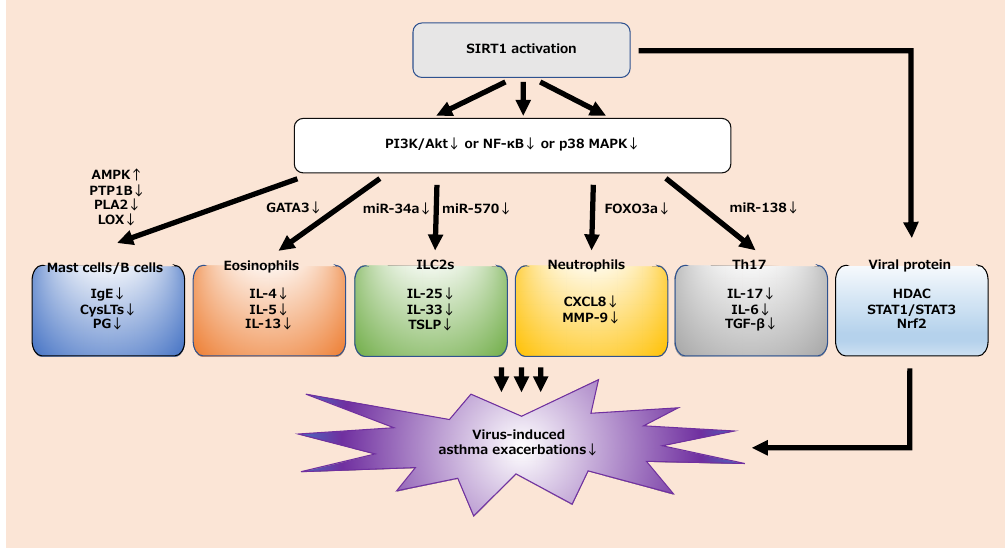
Figure 2. SIRT1-related signaling to virus-induced asthma exacerbations. Activation of SIRT1 promotes the activation of transcription factors, enzyme activity, and viral proteins through PI3K / Akt, NF- κ B, and p38 MAPK signaling. As a result, proinflammatory cytokines and chemokines related to mast cells / B cells, eosinophils, ILC2, neutrophils, and Th17 are